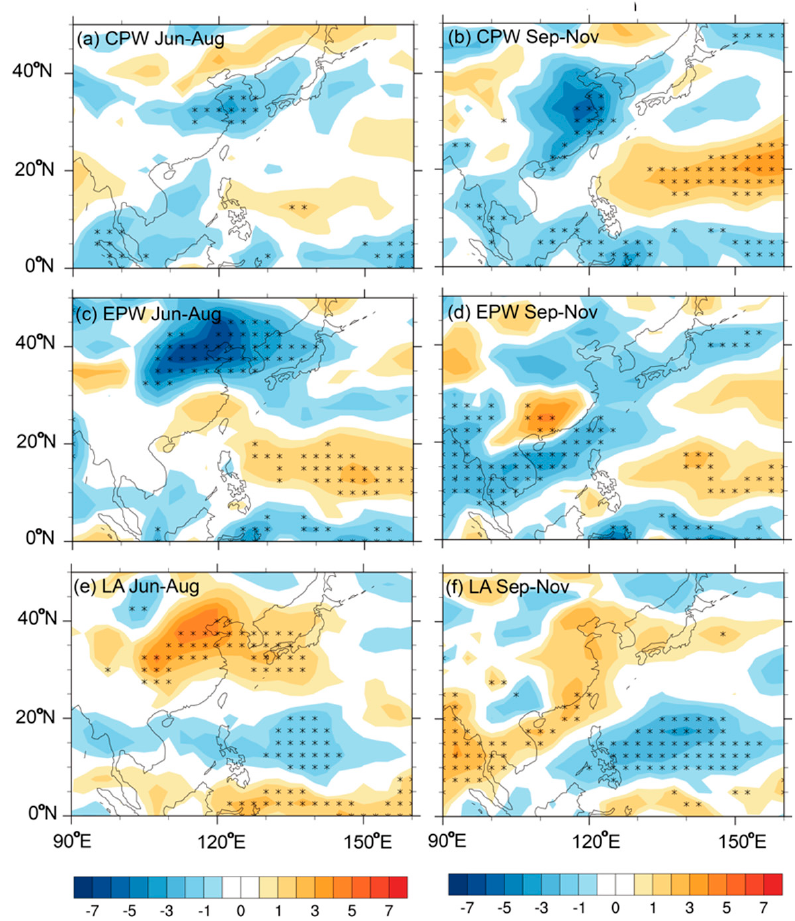
Figure 8. Composite anomalies of relative humidity (RH, %) at 850 hPa for JJA ( a , c , e ) and SON ( b , d , f ) seasons during CPW ( a , b ), EPW ( c , d ) and LA ( e , f ) events. Regions with trends that are significant at 90% confidence are shaded with